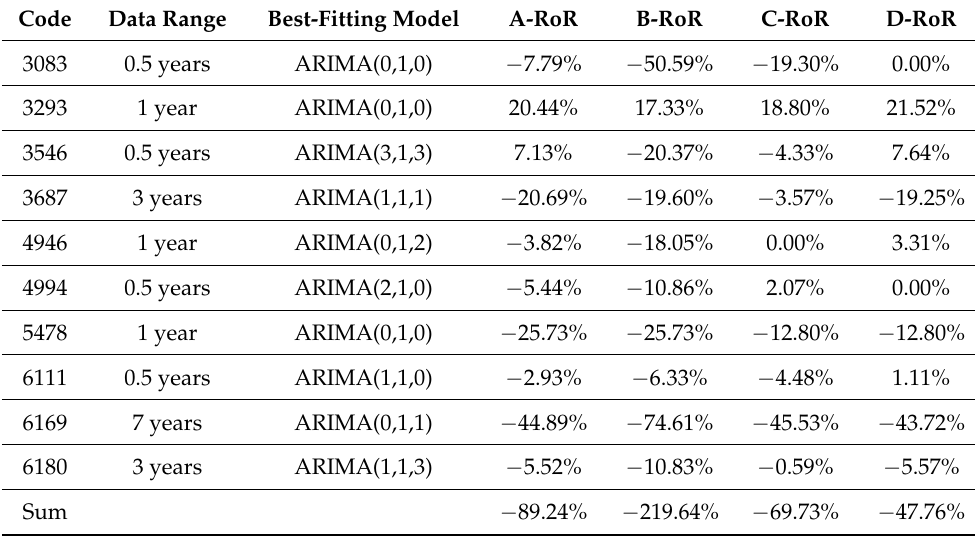
Table 8. Group comparison table of ROR simulation of game